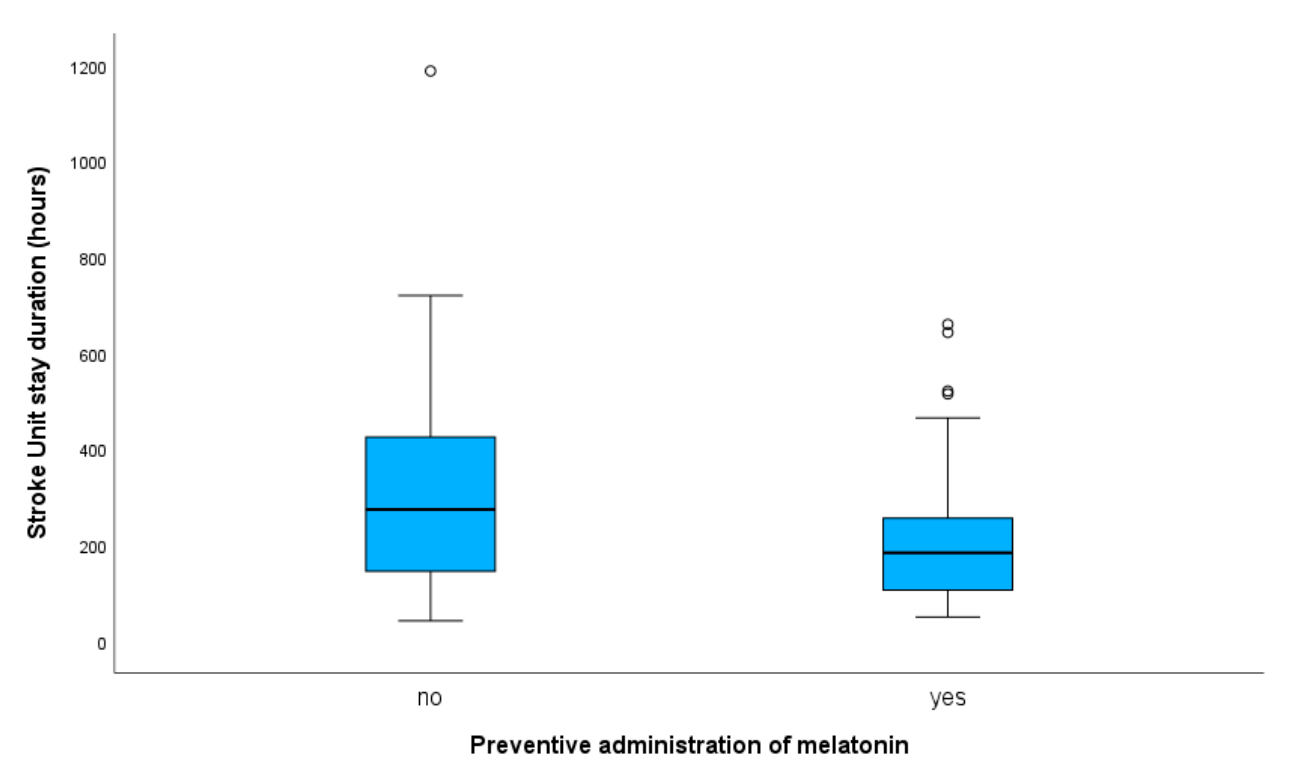
Figure 2. Box plots presenting data for stroke-unit-stay duration (hours) in respect to administration (or not) of melatonin in post-intracerebral hemorrhage patients with post-stroke delirium. In the box plot, the black line within a box indicates the median, the boundary of the box closest to zero indicates the 1st quartile, and the boundary of the box farthest from zero indicates the 3rd quartile. Outliers with values more than 1.5 IQRs, but less than 3 IQRs from the end of the box, are denoted with a circle (o). Whiskers above and below the box indicate max and min values, respectively, not including outliers. Median stroke-unit-stay duration of post-stroke delirium patients receiving melatonin was 184 h, and 274 h in the control group ( p -value for Mann–Whitney U test = 0.033). Table 5. Effect of melatonin administration on SU-stay